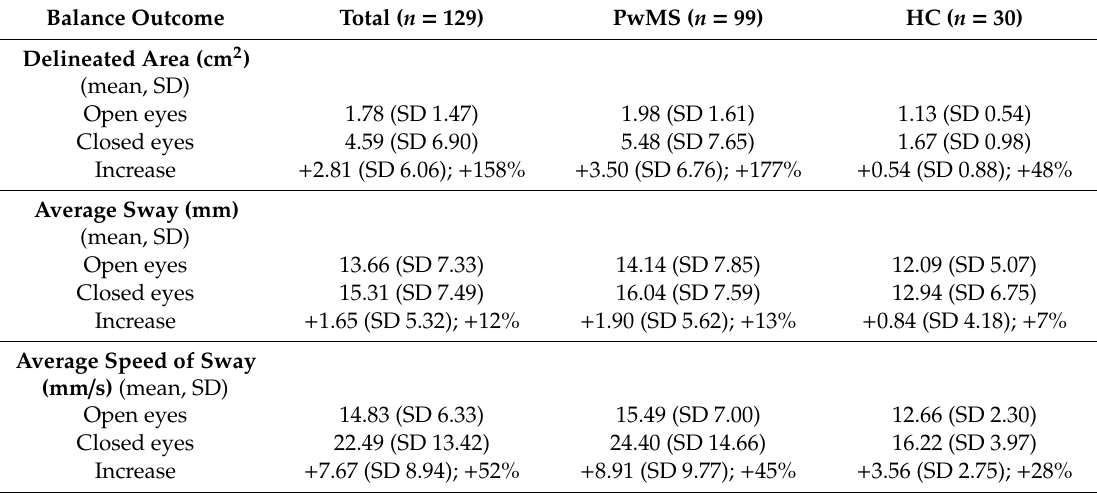
Table 2. Static posturography parameters in open and closed eyes conditions and di ff erence between both in PwMS and HC.